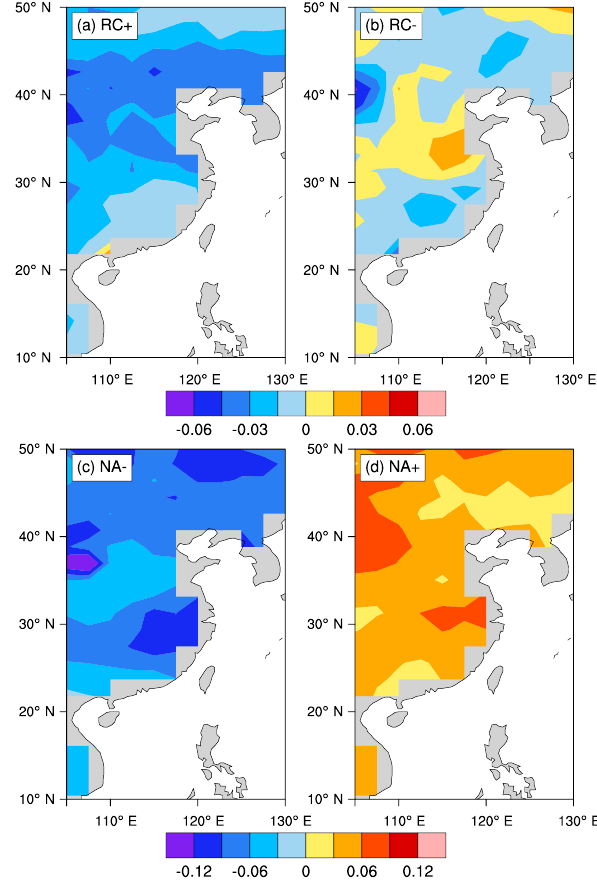
Figure 12. The summer surface temperature anomalies during the (a) high (RC + ) and (b) low (RC-) EASM–precipitation relationship intervals in the CESM-LME full-forcing experiments; panels (c) and (d) are the same as (a) and (b) but for the cold (NA-) and warm (NA + ) phases of summer SSTs over the North Atlantic, respec- tively. The RC + (NA + ) and RC − (NA − ) are selected for the pe- riods that the EASM–precipitation relationship (summer SSTs over the North Atlantic) exceeds its 1.2 and − 1.2 standard deviations, respectively (units: ◦